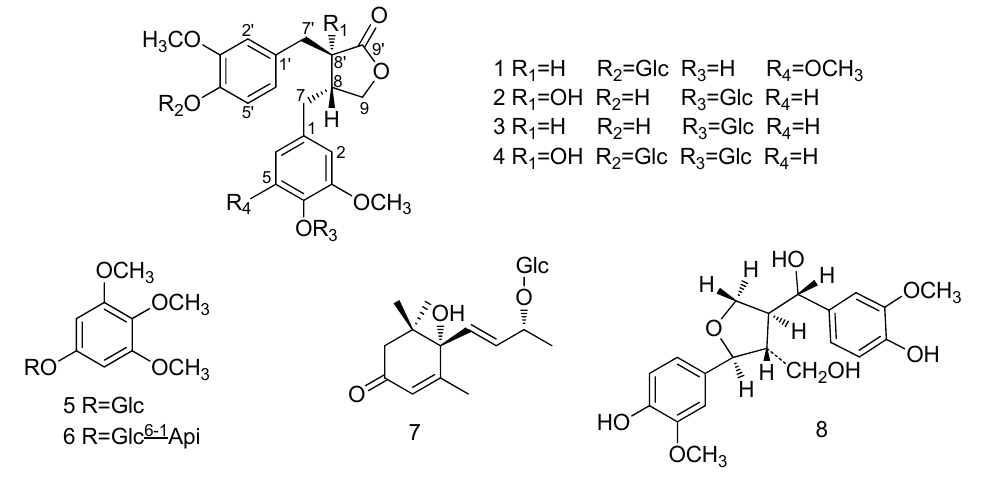
Figure 1. Chemical structures of compounds 1 – 8